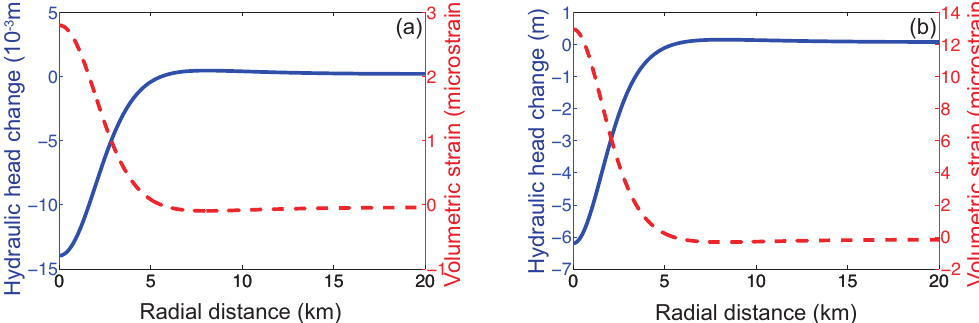
Figure 2. Results of the reference simulation, shown as the initial (i.e. 10 − 6 s) hydraulic head change (blue, solid line) and volumetric strain (red, dashed line) along profiles through the two aquifer types due to a magma chamber pressurization of 10MPa. (a) pyroclastic aquifer, (b) lava flow aquifer. Both aquifers show a fall in hydraulic head mirroring the dilatational strain curves.